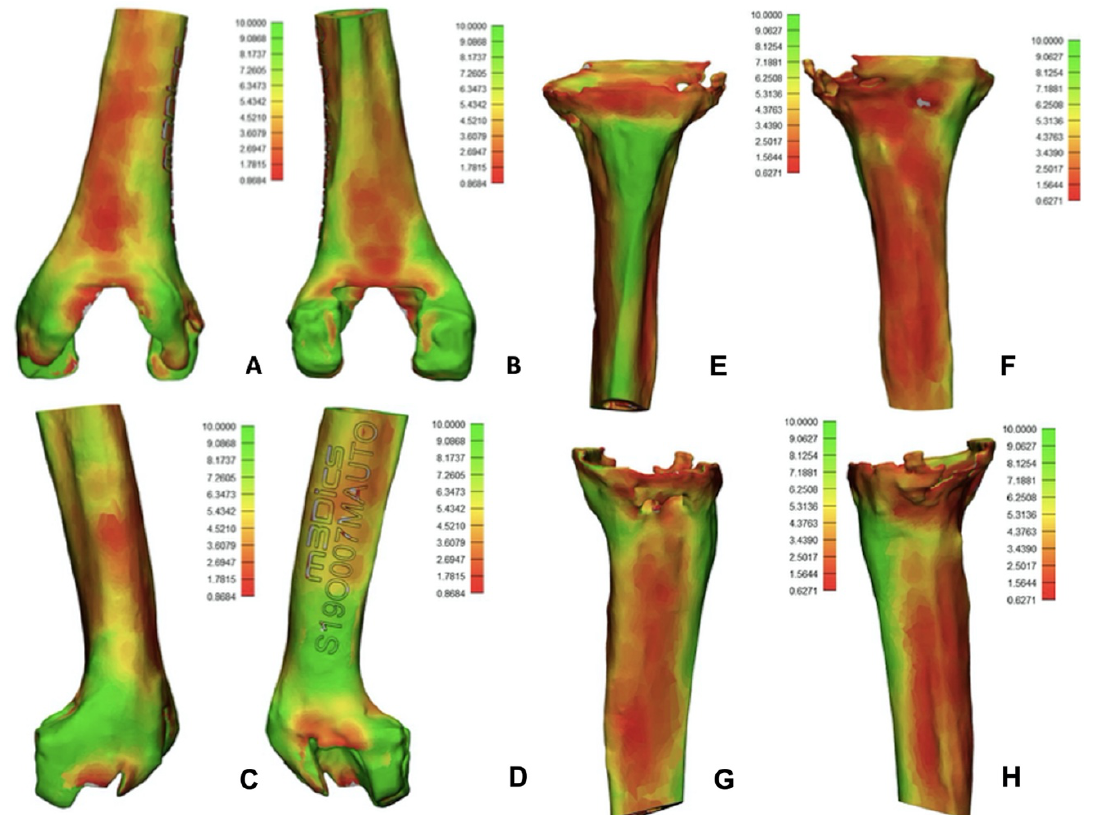
Figure 9. Data provided with the 3D model regarding bone thickness (low thickness red color, high thickness green color). ( A ) Anterior femur; ( B ) posterior femur; ( C ) medial femur; ( D ) lateral femur. Al the femoral images showed low bone thickness at the femoral cortex. ( E ) anterior tibia; ( F ) posterior tibia; ( G ) medial tibia; ( H ) lateral tibia. All tibial images show poor bone thickness except for anterior tibial cortex.